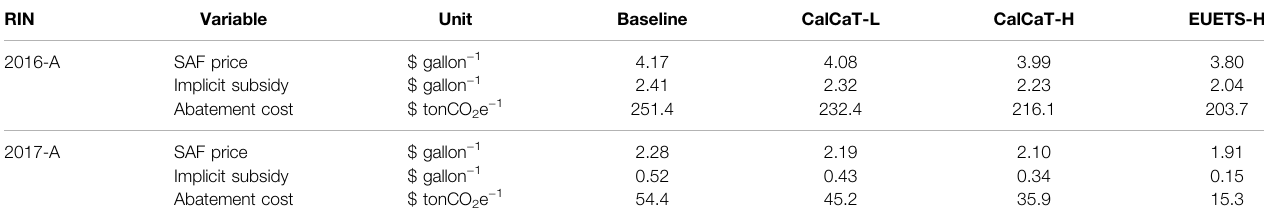
TABLE 6 | GHG emission abatement costs with feedstock price at $90 ton − 1 . RIN